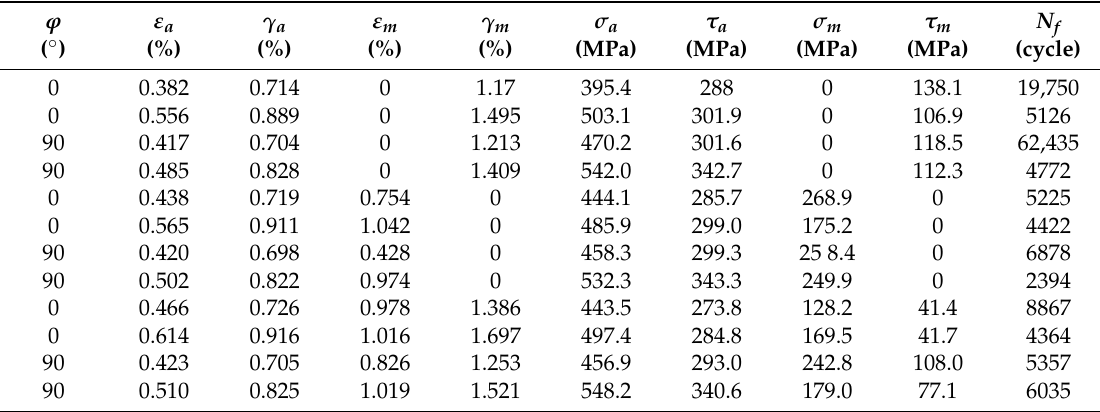
Table 4. The experimental data for TC4 under asymmetric